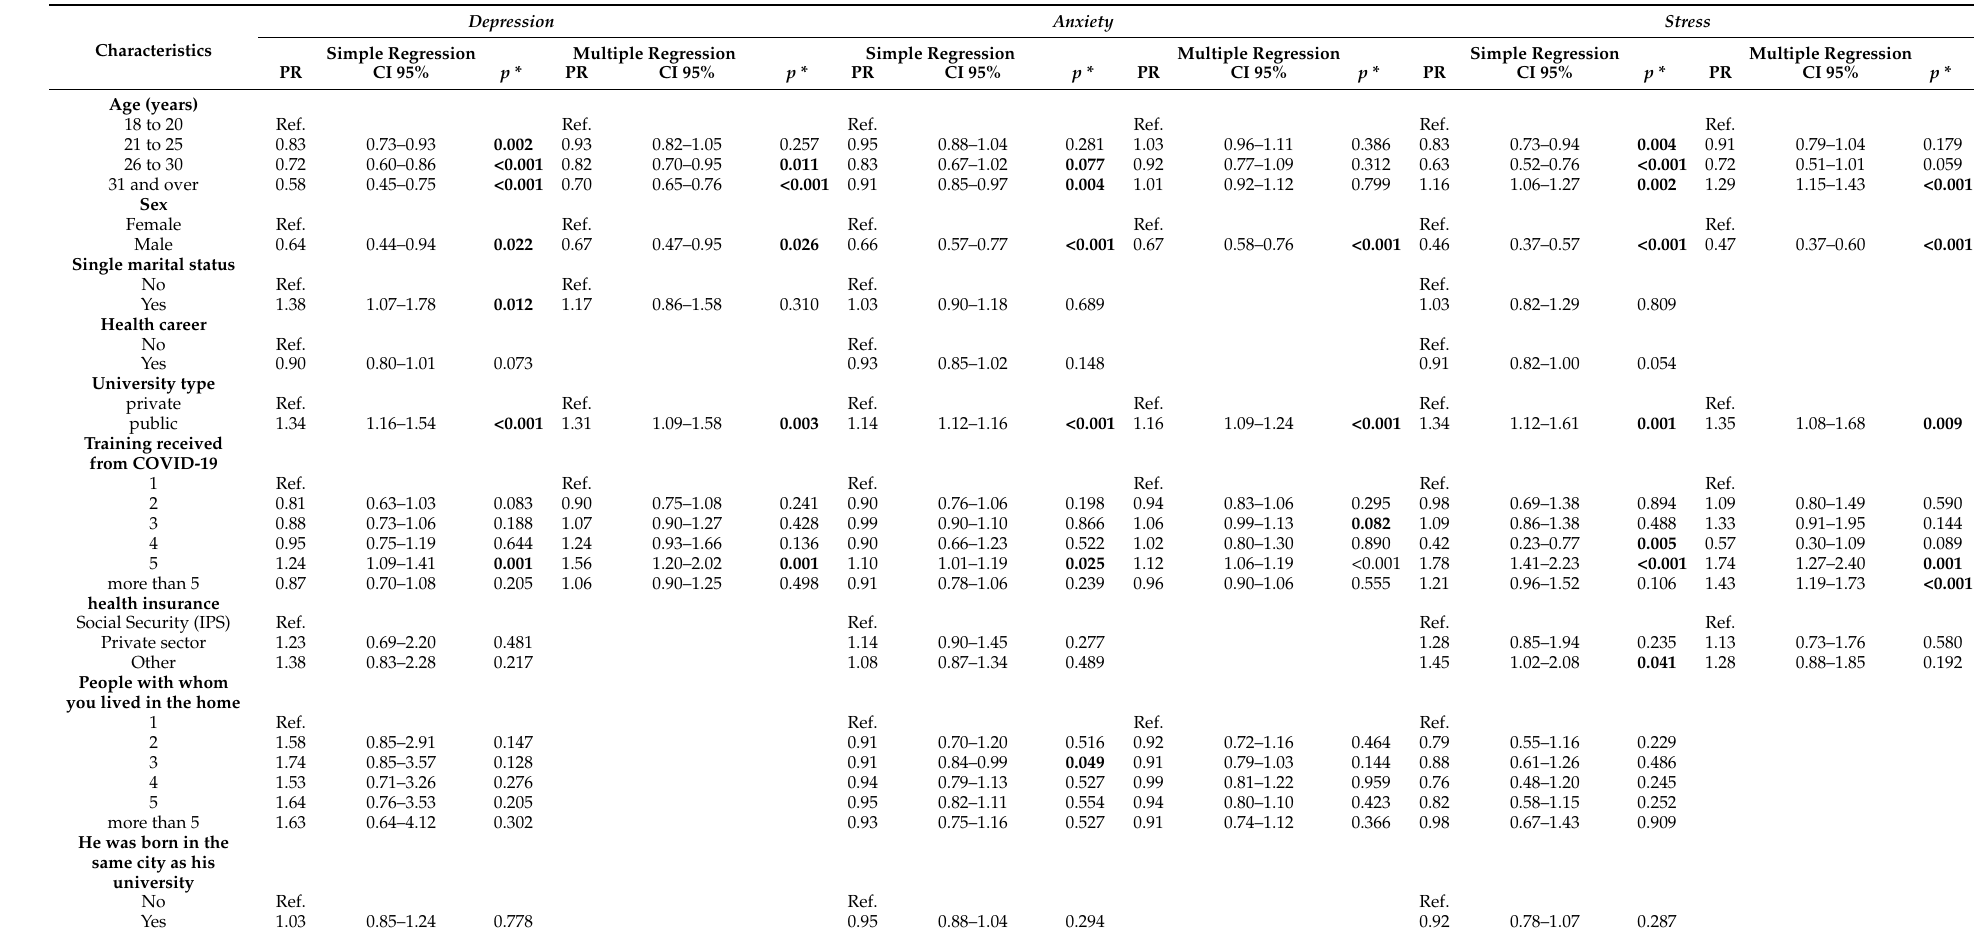
Table 3. Factors associated with depression, anxiety, and stress in multiple regression